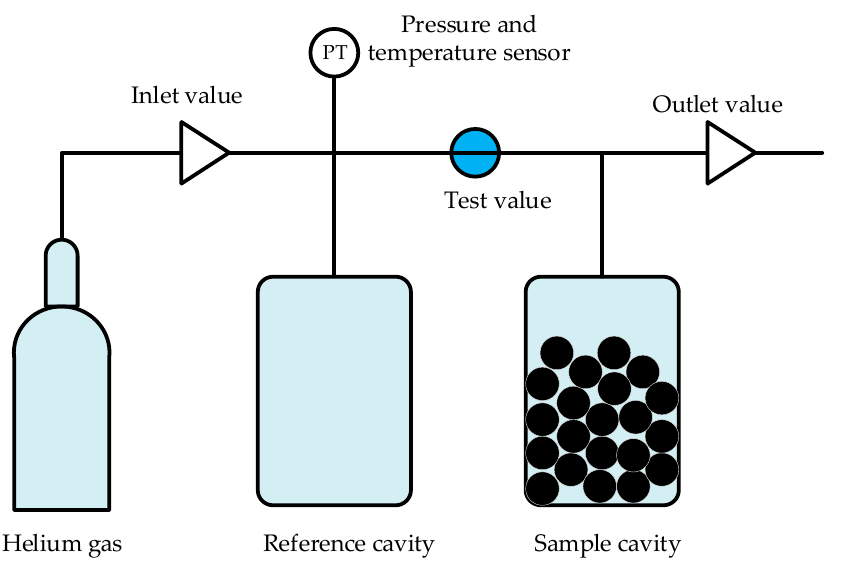
Figure 2. Measurement of particle porosity.